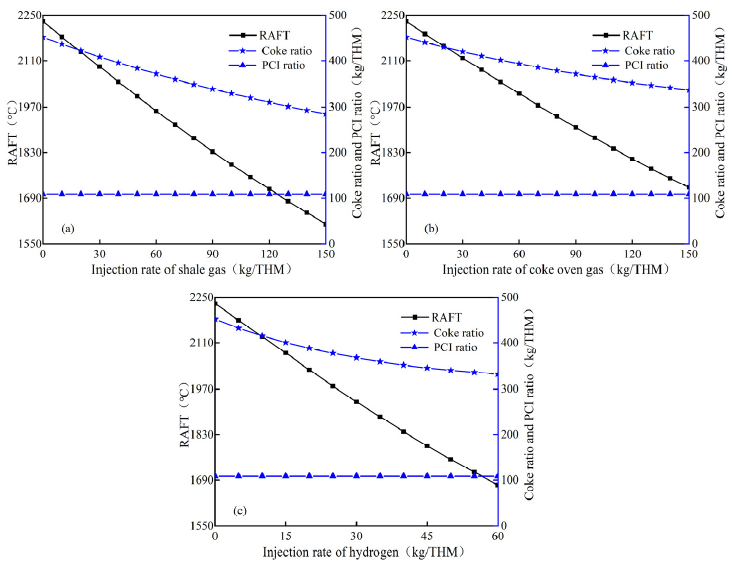
Figure 3. Influence of hydrogen − rich gas injection quantity on the RAFT: ( a ) shale gas; ( b ) coke oven gas; ( c ) hydrogen.